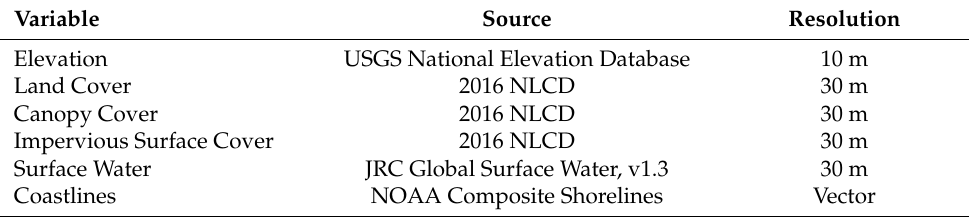
Table A1. Covariate data layers and sources.